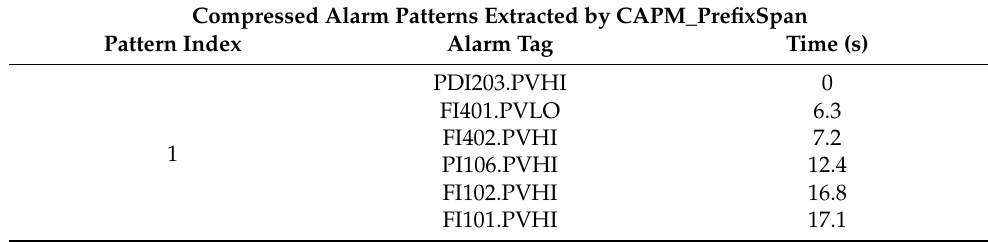
Table 11. Compressed alarm patterns obtained by